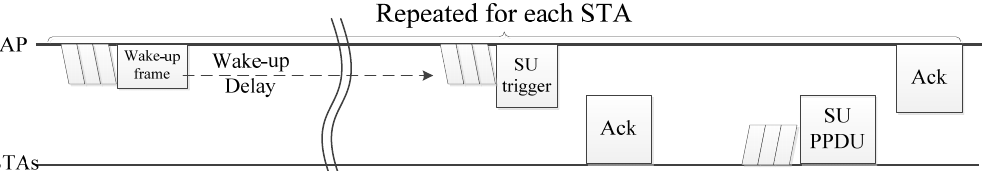
Figure 7. Data transmission procedure to gather the sensed data from sensors operated in application layer based on unicast transmission. SU = single user; SU PPDU = single user physical layer protocol data unit.